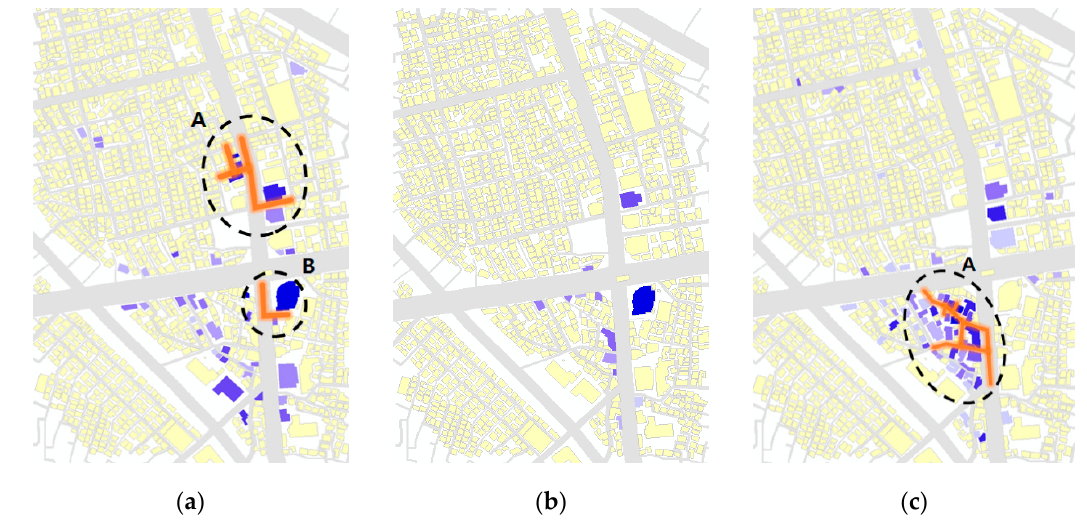
Figure 9. Themed street cluster detection results in Sillim test area: ( a ) Café themed street; ( b ) Fashion themed street; ( c ) Pub themed street.